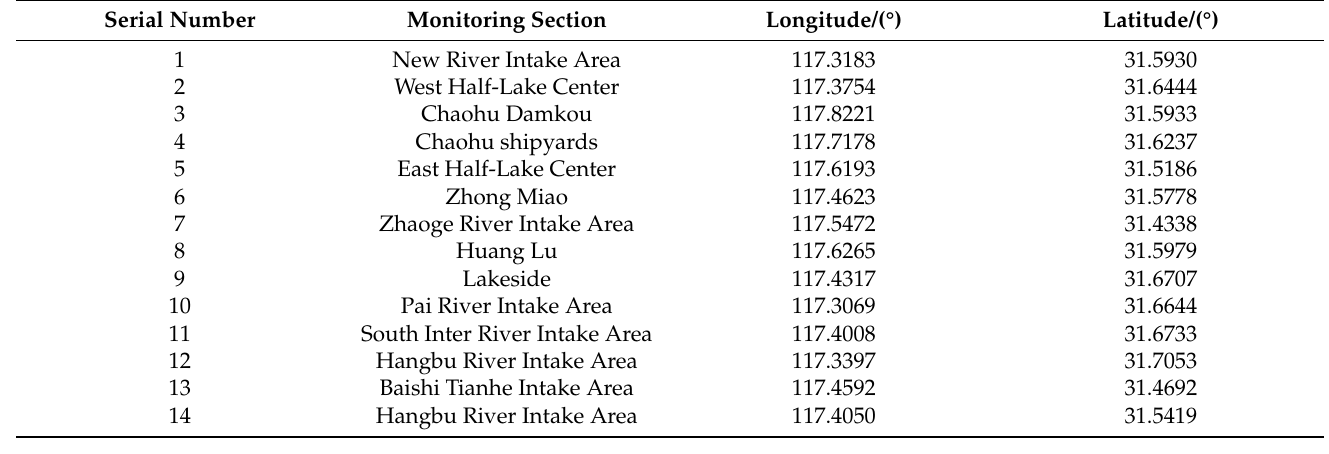
Table 1. Longitude and latitude distribution of Chaohu water quality monitoring section.